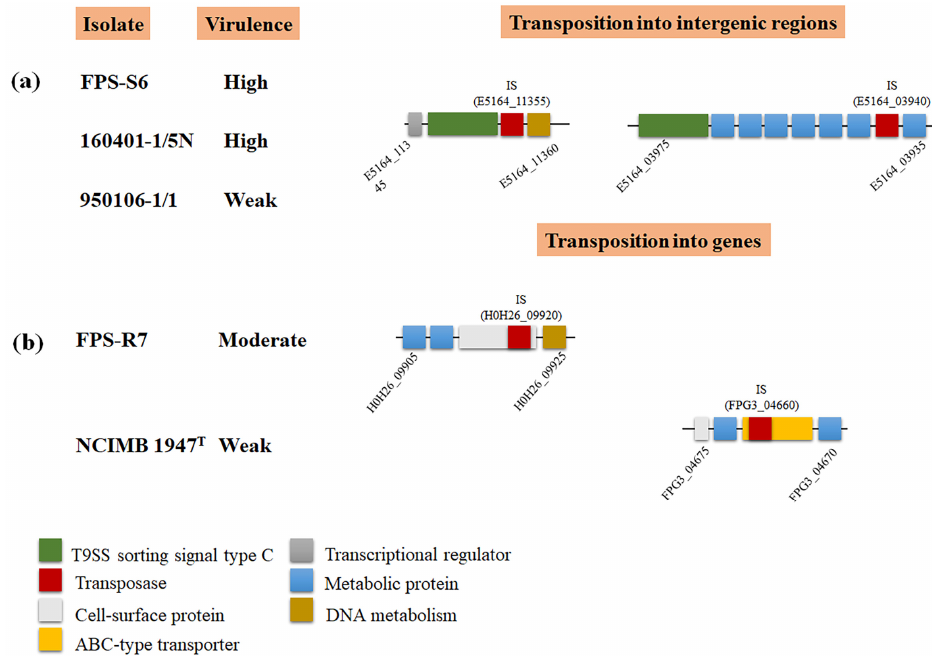
Figure 5. Selected examples of transposon insertion in F. psychrophilum isolates. ( a ) Example of IS transposition into intergenic regions. ( b ) Example of IS in encoding genetic regions. Genes are represented as squares; insertions of transposases into genes are represented by red squares. Gene functional categories are shown by colored boxes. Isolates, loci tags, and virulence phenotype were added in the figure to facilitate comparison.